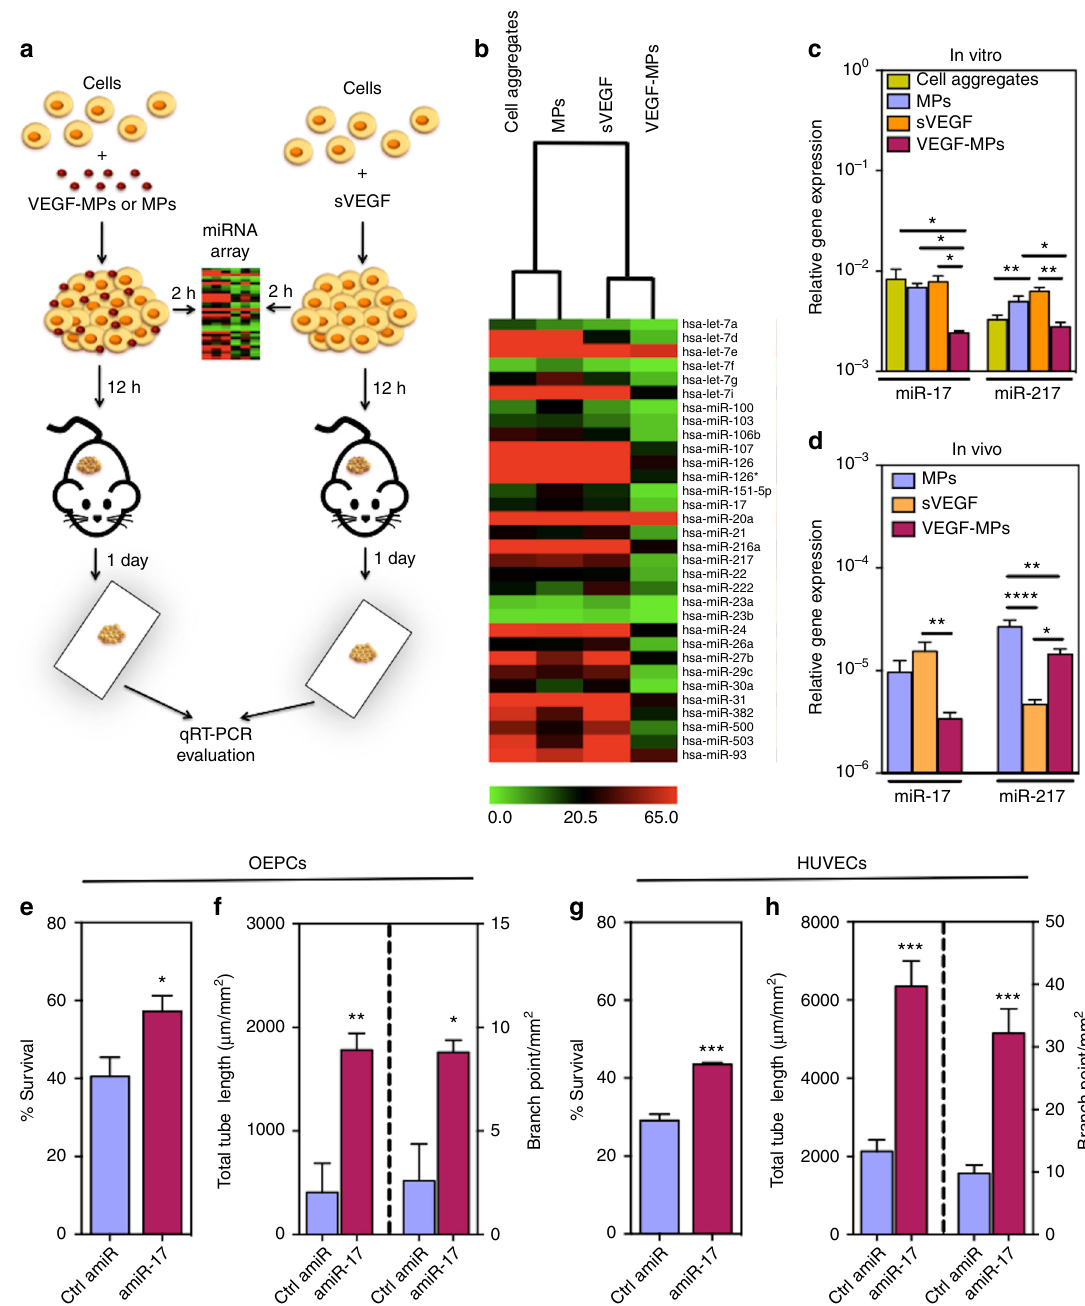
Fig. 4 Identi fi cation of a miRNA associated with the function of OEPCs after contact with VEGF-MPs. a Schematic representation of the protocol used to identify miRNAs mediating the effect of VEGF-MPs. b Differentially regulated miRNAs ( P < 0.05) in OEPC aggregates cultured in vitro for 2 h as evaluated by miRNA array. c Validation of some miRNAs by qRT-PCR. d miRNA expression as evaluated by qRT-PCR in OEPC aggregates implanted subcutaneously in mice for 1 day. U6 was used to normalize the data. In all graphs, values are given as average ± SEM ( n = 3 – 4). Statistical analyses were performed using one-way ANOVA followed by a Bonferroni post test. * P ≤ 0.05,** P ≤ 0.01,*** P ≤ 0.001, and **** P ≤ 0.0001. e , g Survival of OEPCs ( e ) or HUVECs ( g ) transfected with control antagomiR (Ctrl amiR) or antagomiR-17 ( amiR-17 ), in serum-deprived conditions for 48 h under hypoxia conditions (0.1% O 2 ), as assessed by Presto-Blue assay. f , h Transfected OEPCs or HUVECs with Ctrl amiR or amiR-17 were cultured on Matrigel for 48 h under hypoxia after which the tube length and branching points were measured. In all graphs, values are given as average ± SEM ( n = 4). An unpaired t -test was performed for statistical analysis between Ctrl amiR and amir-17 groups. * P ≤ 0.05, ** P ≤ 0.01, and *** P ≤